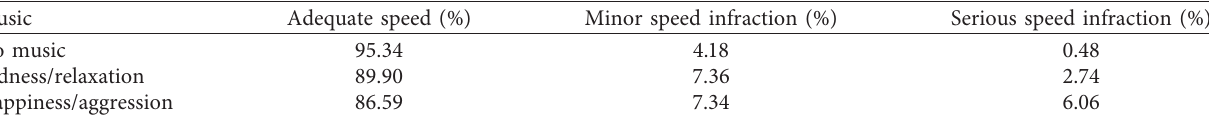
Table 6: Probability of speed violation in relation to the music.